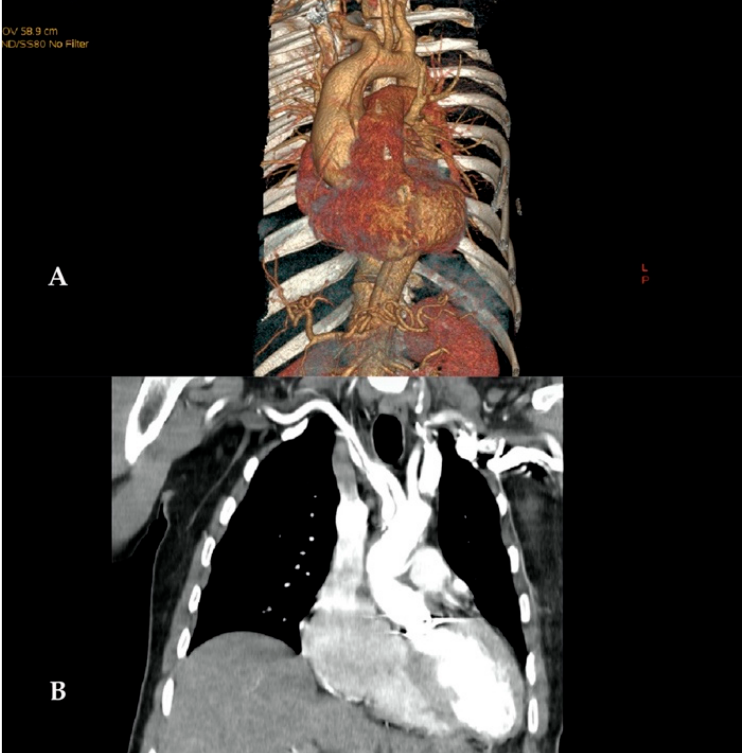
Figure 4. Admission CT scan of a 34-year-old patient with AAAD, anuloaortic ectasia, and a dissection extending well into the innominate artery ( A ). Control CT scan, 6 months after composite replacement of the aortic root and ascending aorta using innominate artery cannulation. The innominate trunk is still dissected with a patent false lumen ( B